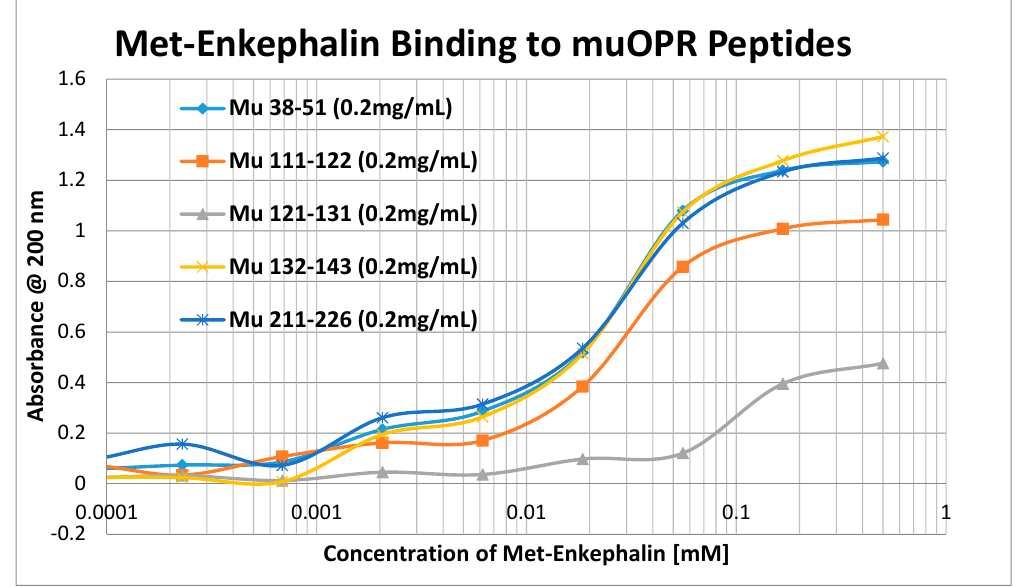
Figure 8. UV spectroscopic study of methionine enkephalin binding to mu opioid receptor (muOPR) peptides derived from the extracellular loop and adjacent transmembrane regions (see Figure 1). Table 2. Binding constants (in micromoles) of various bioactive compounds for the receptor peptides listed in Table 1.